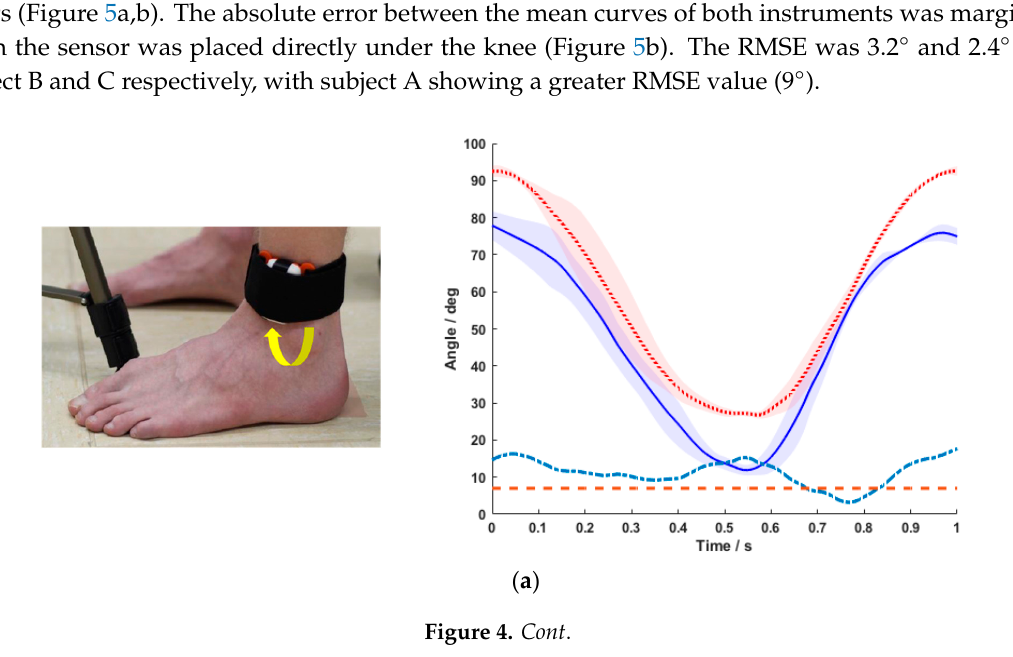
Table 2. Root Mean Squared Errors (RMSE) for all subjects in each test situation.